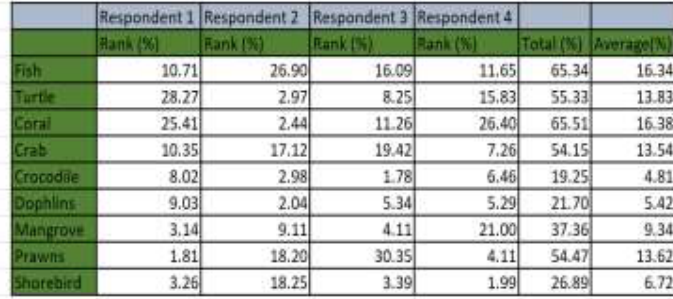
Table 5: Aggregation of priority weights of all experts